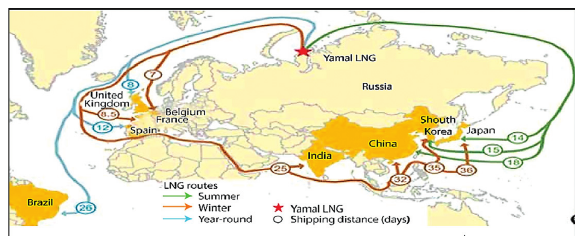
Figure 11: Yamal LNG and Arctic route for fuel shipping [66,